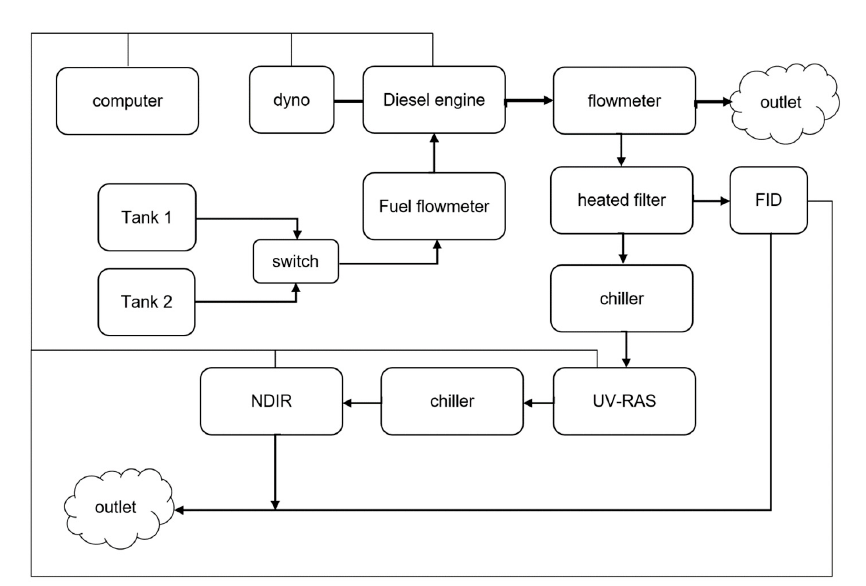
Figure 2. The measurement layout.